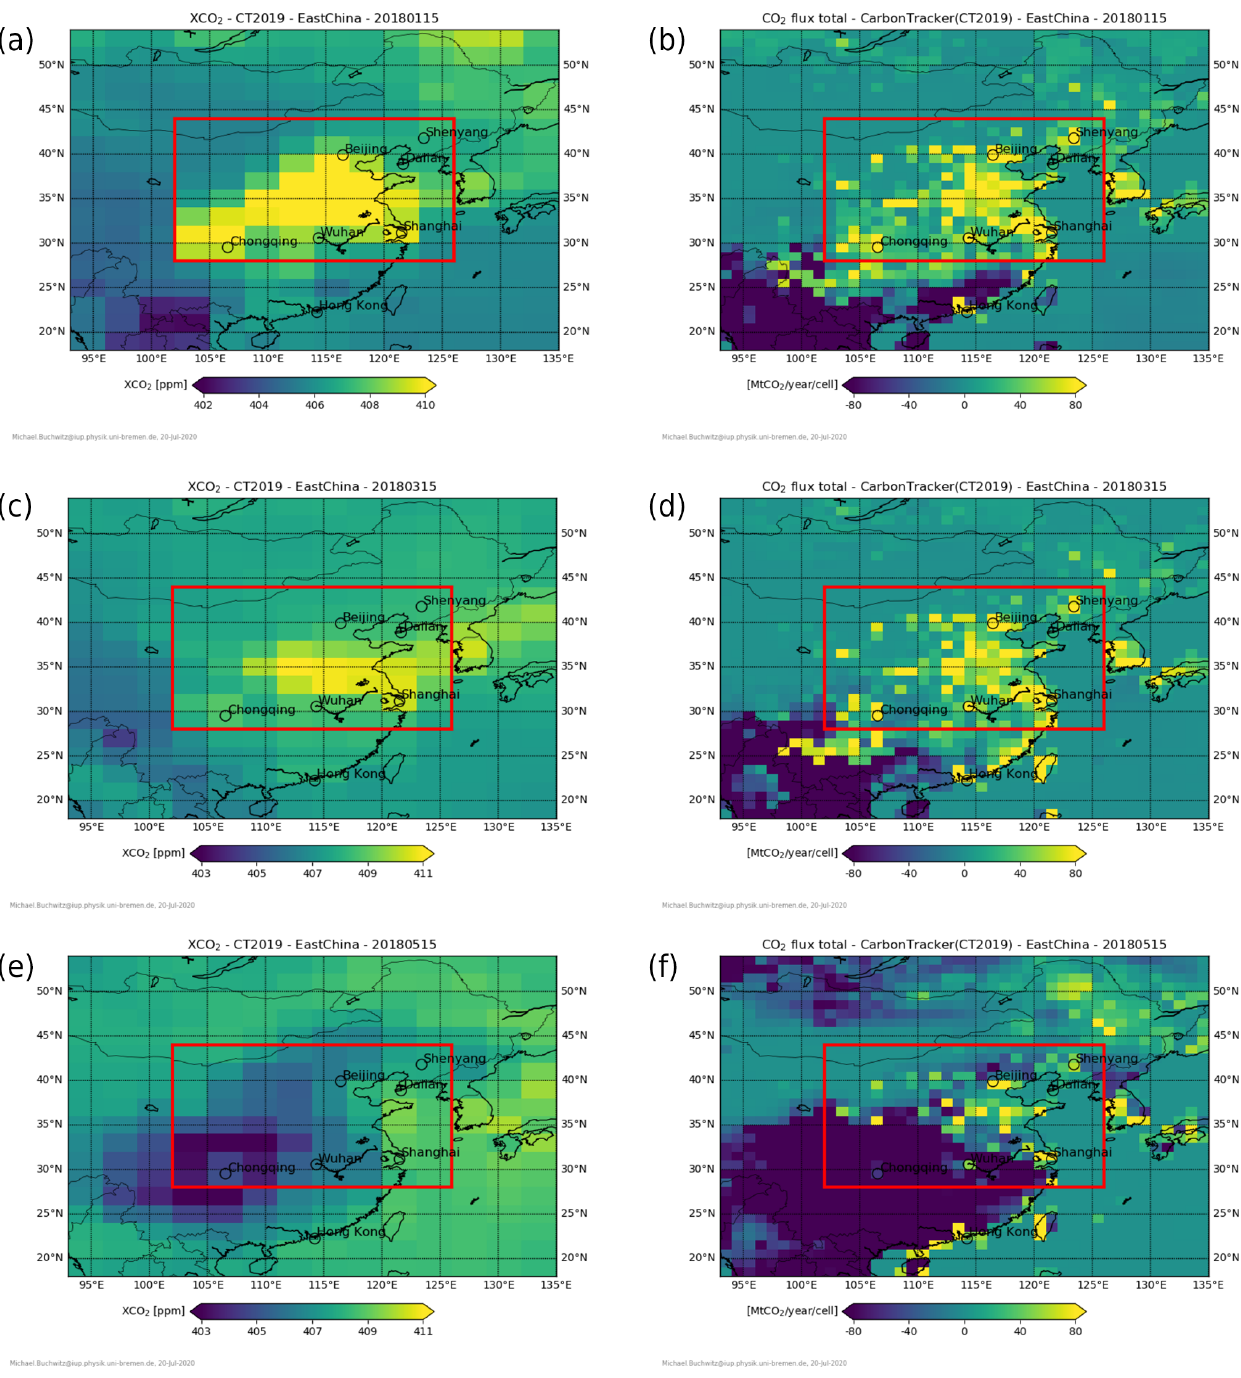
Figure 1. CT2019 XCO 2 ( a, c, e , in ppm) and corresponding CO 2 surface fluxes ( b, d, f , in MtCO 2 yr − 1 per cell) for 15 January 2018 (a, b) , 15 March 2018 (c, d) and 15 May 2018 (e, f) . The red rectangle encloses the East China target region as defined for this study.